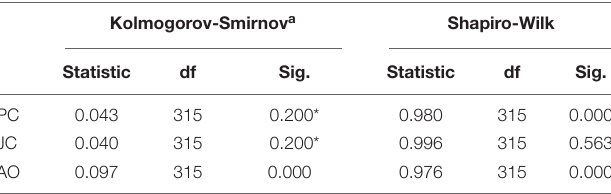
TABLE 2 | Tests of